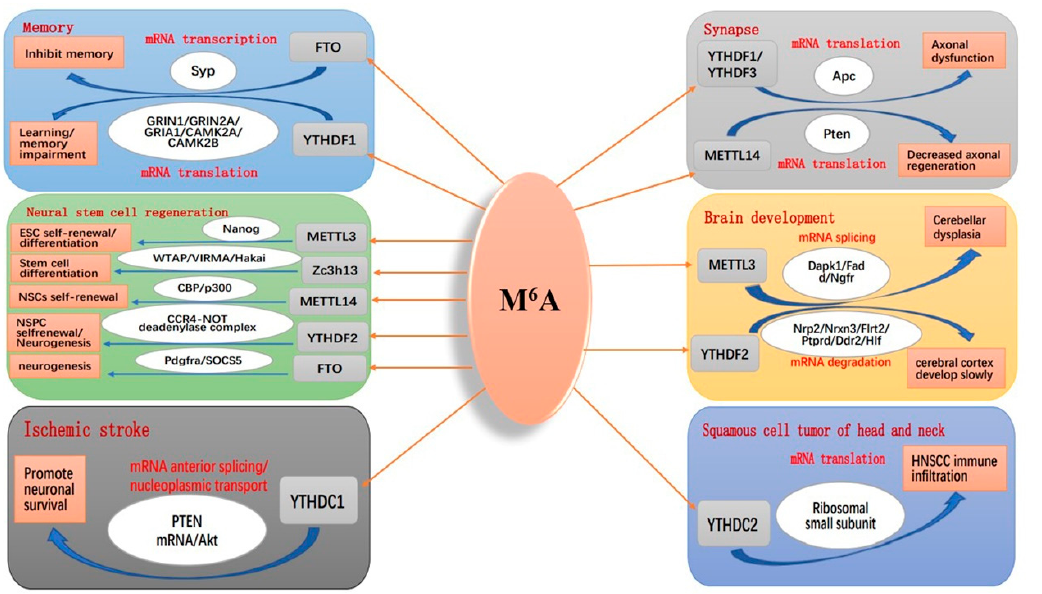
Figure 7. The role of m 6 A modification in the CNS.